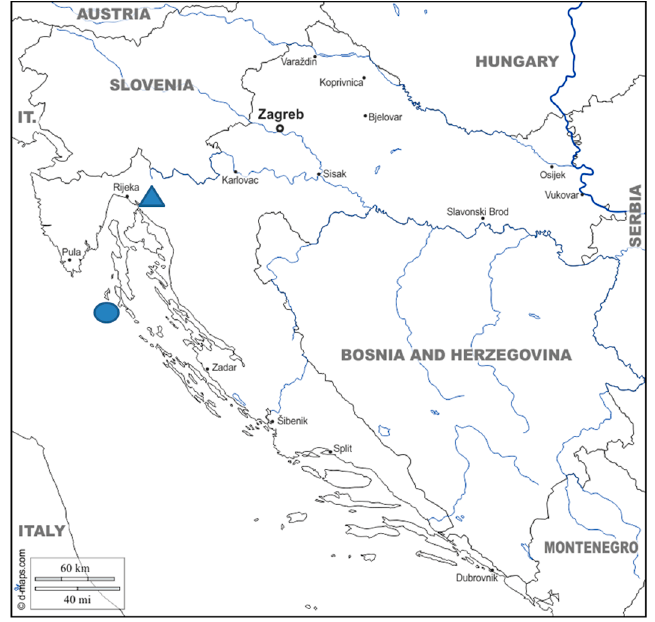
Figure 1. Location of the two studied populations ( ▲ = town of Bakar; ● = town of Mali Lošinj). Background map source: https://d-maps.com/carte.php?num_car=14898&lang=en.